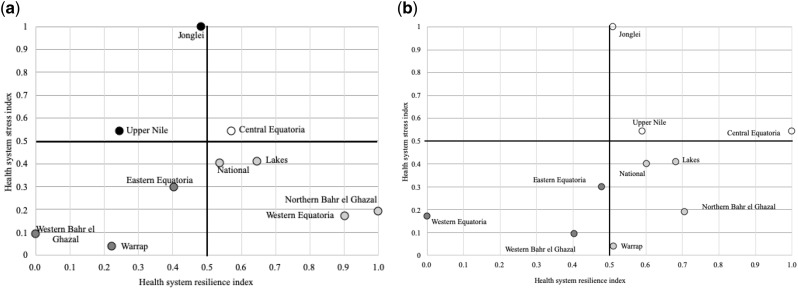
(a) Health system resilience and stress matrix at state and national levels in South Sudan focused on maternal and newborn health. (b) Health system resilience and stress matrix at state and national levels in South Sudan focused on child health. () Low resilience and high stress, () Low resilience and low stress, () High resilience and low stress, () High resilience and high stress.